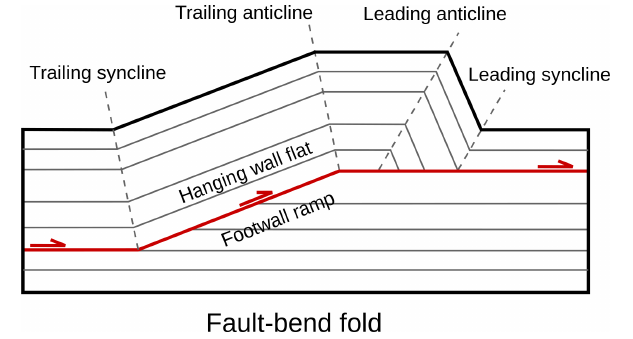
Figure 3. Diagram of the anticlinal fold mountains formed by com- pression. Source: public domain – Wiki